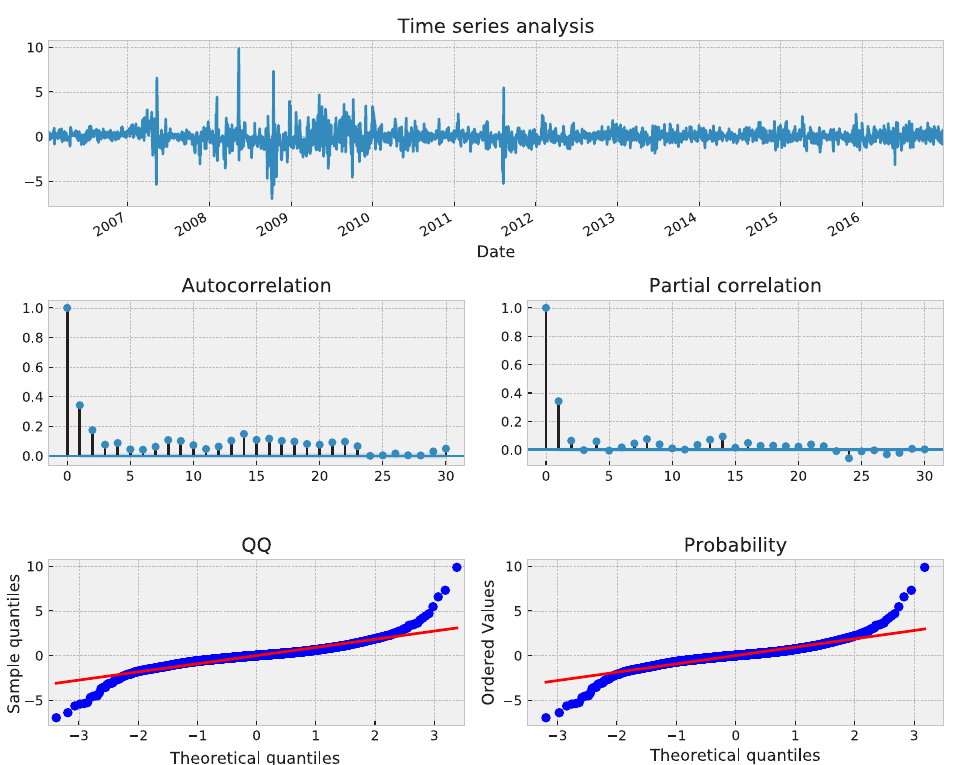
Figure 2. BelexLine autocorrelation test